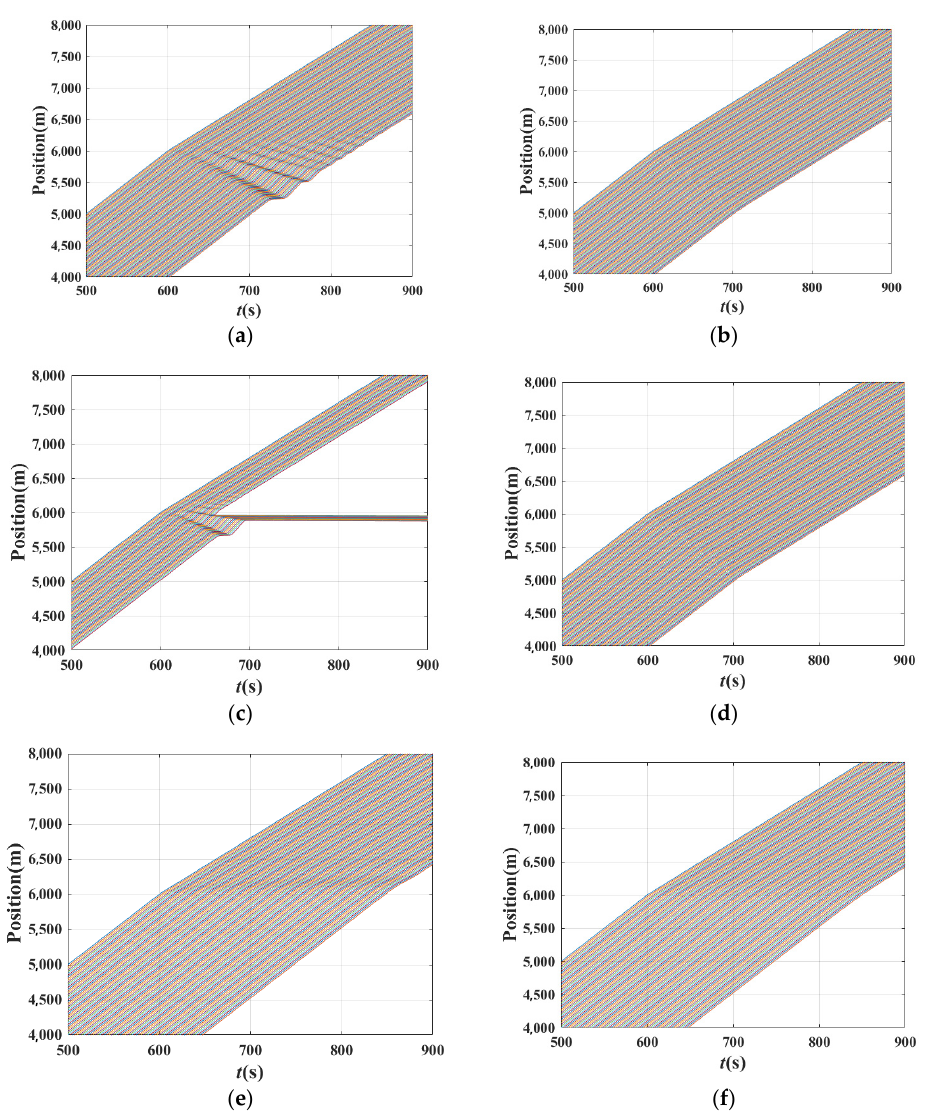
Figure 7. Time–position of the traffic when the basic model is the FVD, OV mode, and ACC model. ( a ) Time–position of the traffic when basic model is the FVD and β 1 = 0, β 2 = 0, ∆ x = 20 m; ( b ) Time– position of the traffic when basic model is the FVD and β 1 = 0, β 2 = 0.8, ∆ x = 20 m; ( c )